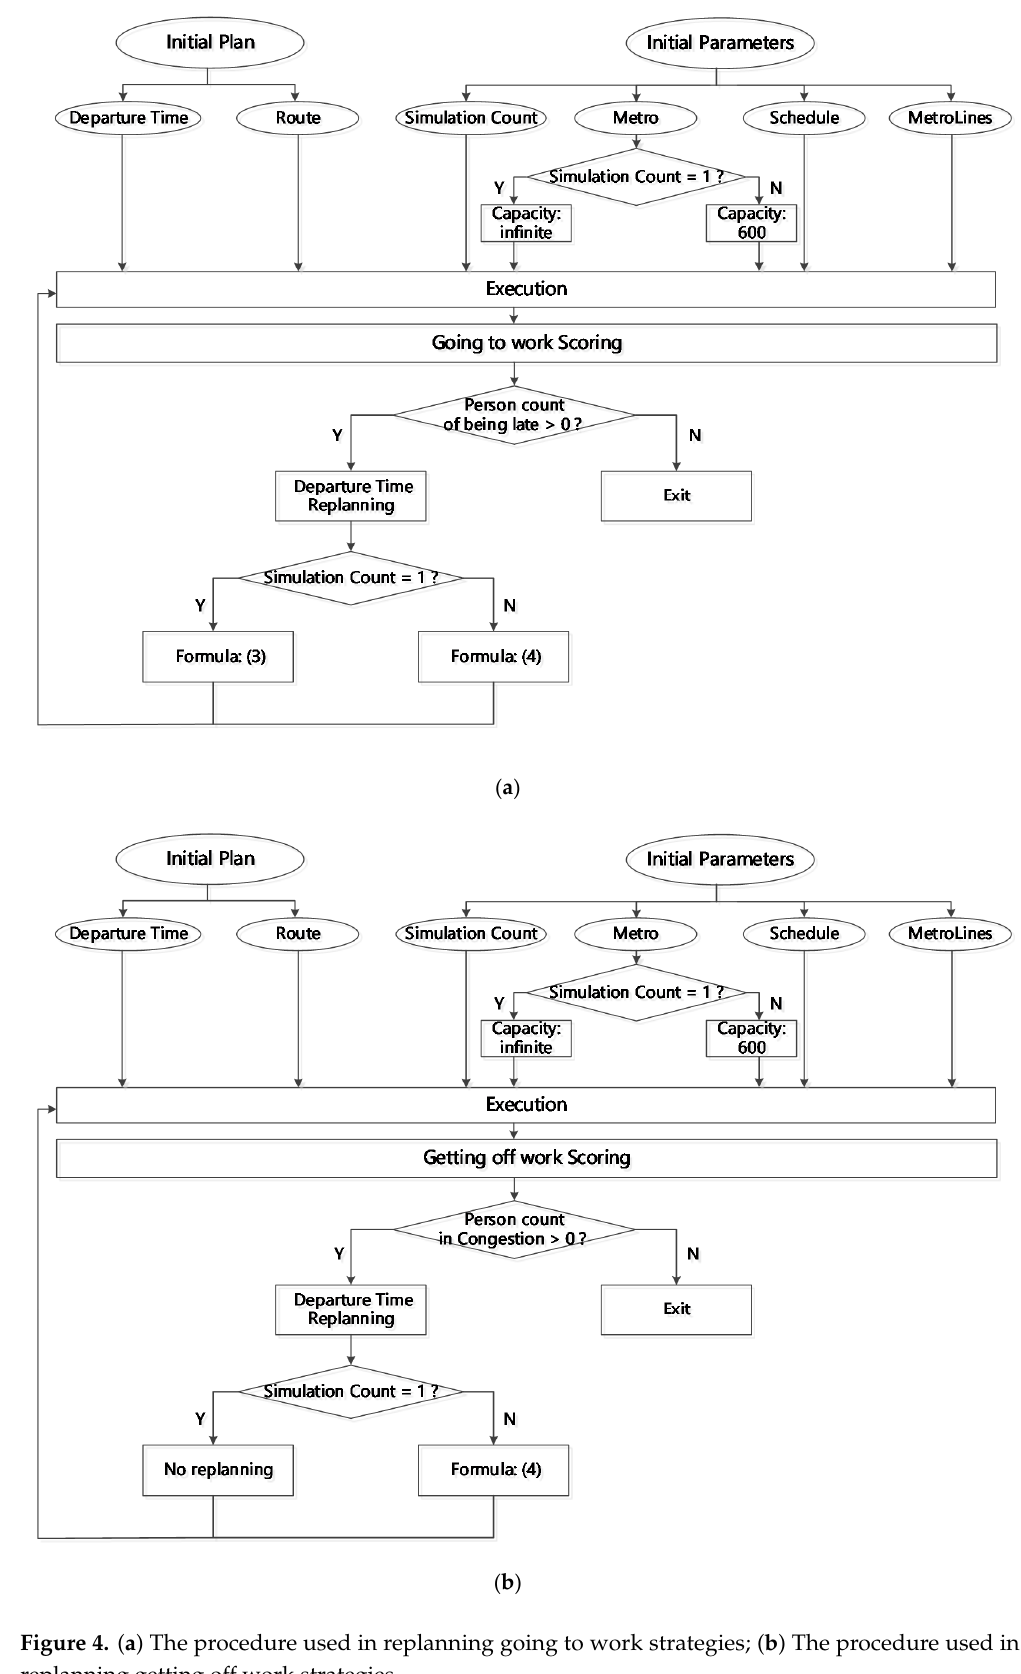
Figure 4. ( a ) The procedure used in replanning going to work strategies; ( b ) The procedure used in replanning getting off work strategies.